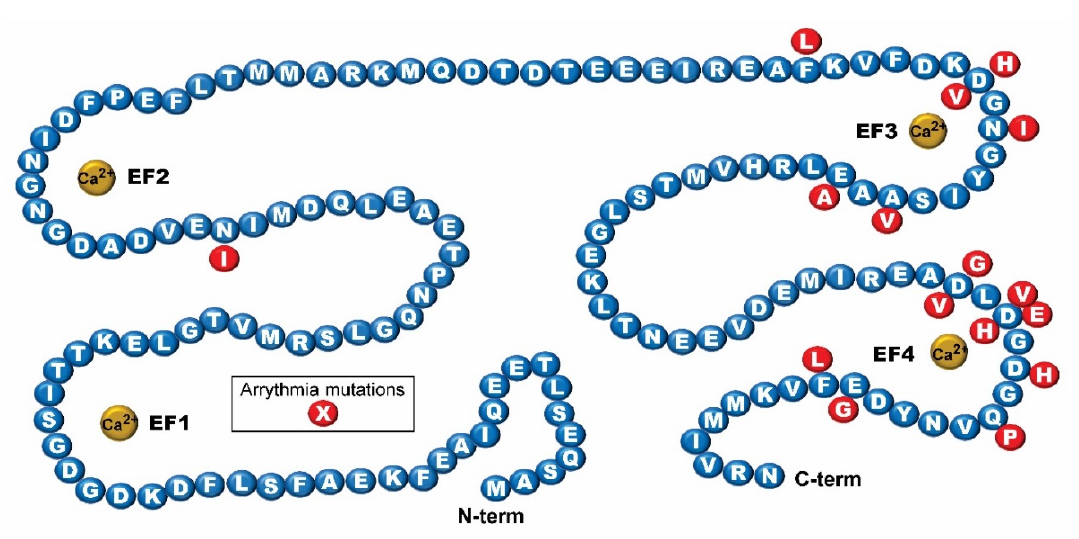
Figure 3. The sequence of Dictyostelium calmodulin showing the location of human calmodulin mutations associated with various arrythmias. Red circles indicate amino acids involved in these calmodulinopathies as detailed in the text. Graphic designed after Figure 1 in [19].